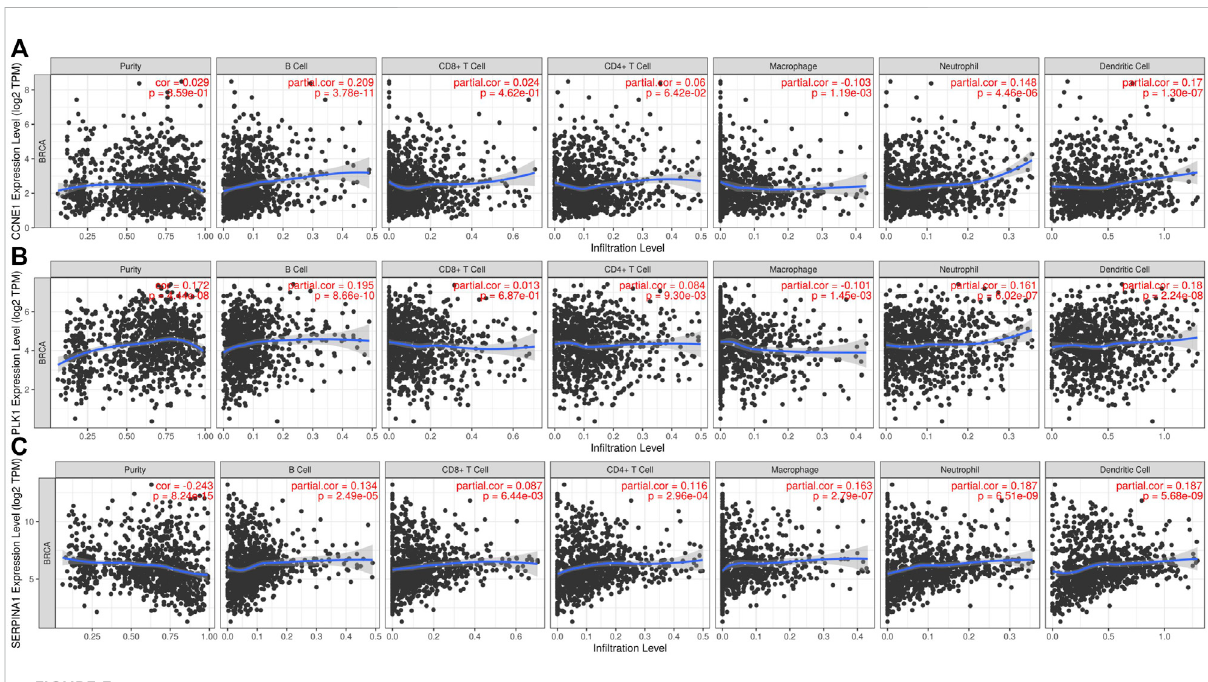
FIGURE 3 Identi fi cation of tumor antigens associated with immune cell in fi ltration. Correlation between the expression levels of (A) CCNE1 , (B) PLK1 , and (C) SERPINA1 and in fi ltration level of immune cells (B cells, CD8 + T-cell, CD4 + T-cells, macrophages, neutrophils, and dendritic